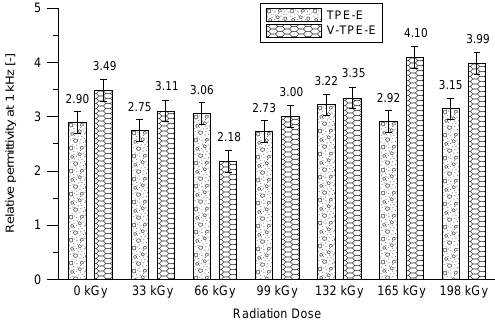
Figure 6. Relative permittivity measured at 1